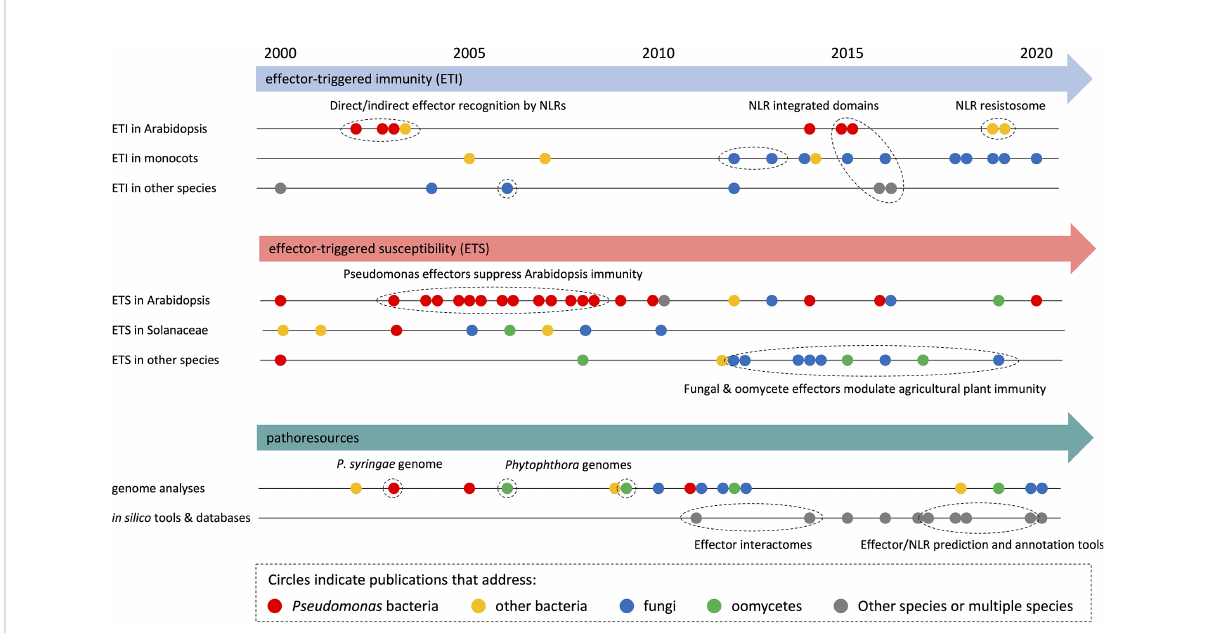
FIGURE 3 HIPEs model objects shifted within the early 2010s. Analytical timeline of selected HIPEs from the three largest categories: effector-triggered immunity (ETI; top panel), effector-triggered susceptibility (ETS; intermediate panel), and pathoresources (bottom panel). HIPEs are shown as dots, which are: i) colored according to the model organism that they mainly address (see legend on top), ii) positioned onto various timeline (see on the left) according to their content, and iii) positioned horizontally according to their publication date. Details are shown for some HIPEs (of coherent groups of HIPEs). Dotted ellipses highlight key HIPEs (or groups of HIPEs) that reported coherent discoveries or addressed linked research questions. The raw data used to build this fi gure are shown in Dataset